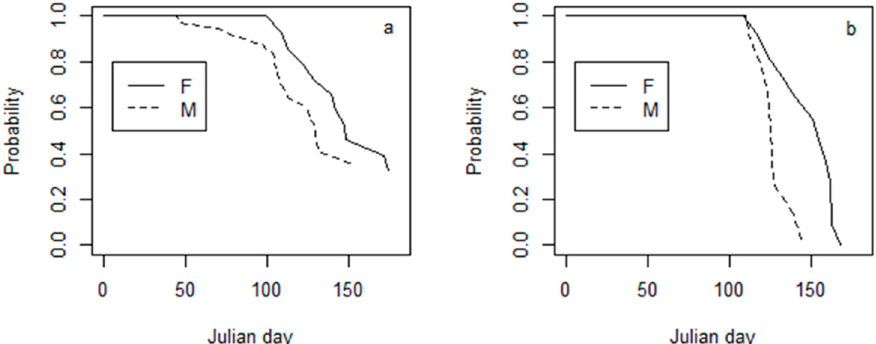
Figure 1. Kaplan–Meier estimates of the daily probability for remaining sedentary at the non-breeding grounds of American white pelicans ( Pelecanus erythrorhynchos ) in ( a ) the Northern and ( b ) Southern Gulf of Mexico, USA, during spring from 2002 to 2011.